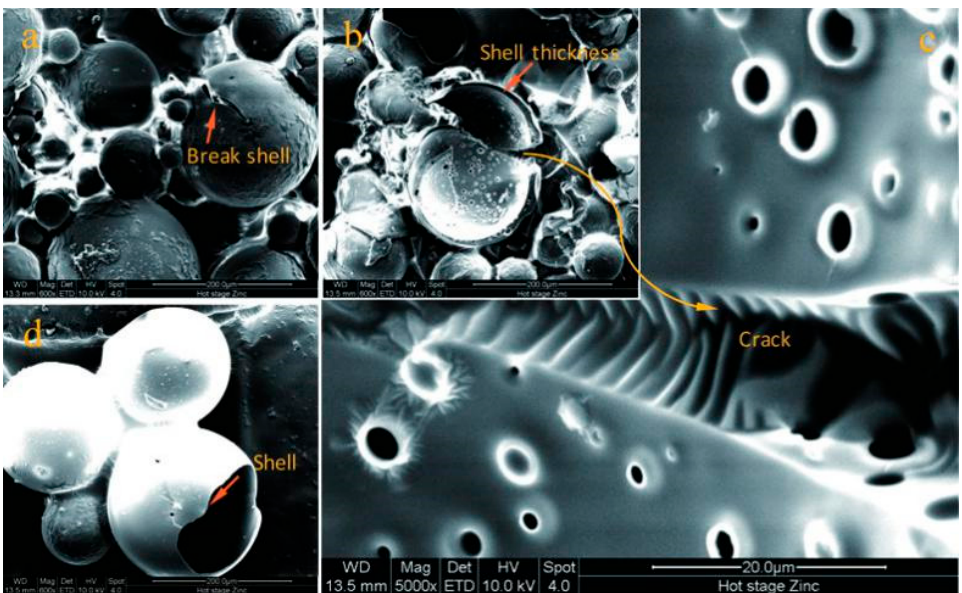
Figure 6. SEM morphologies of typical microcapsules with core-shell structure, ( a ) a microcapsules with a rupture shell, ( b ) a broken shell with measurable thickness, ( c ) the enlarged broken shell, ( d ) the membrane shell of a microcapsule.